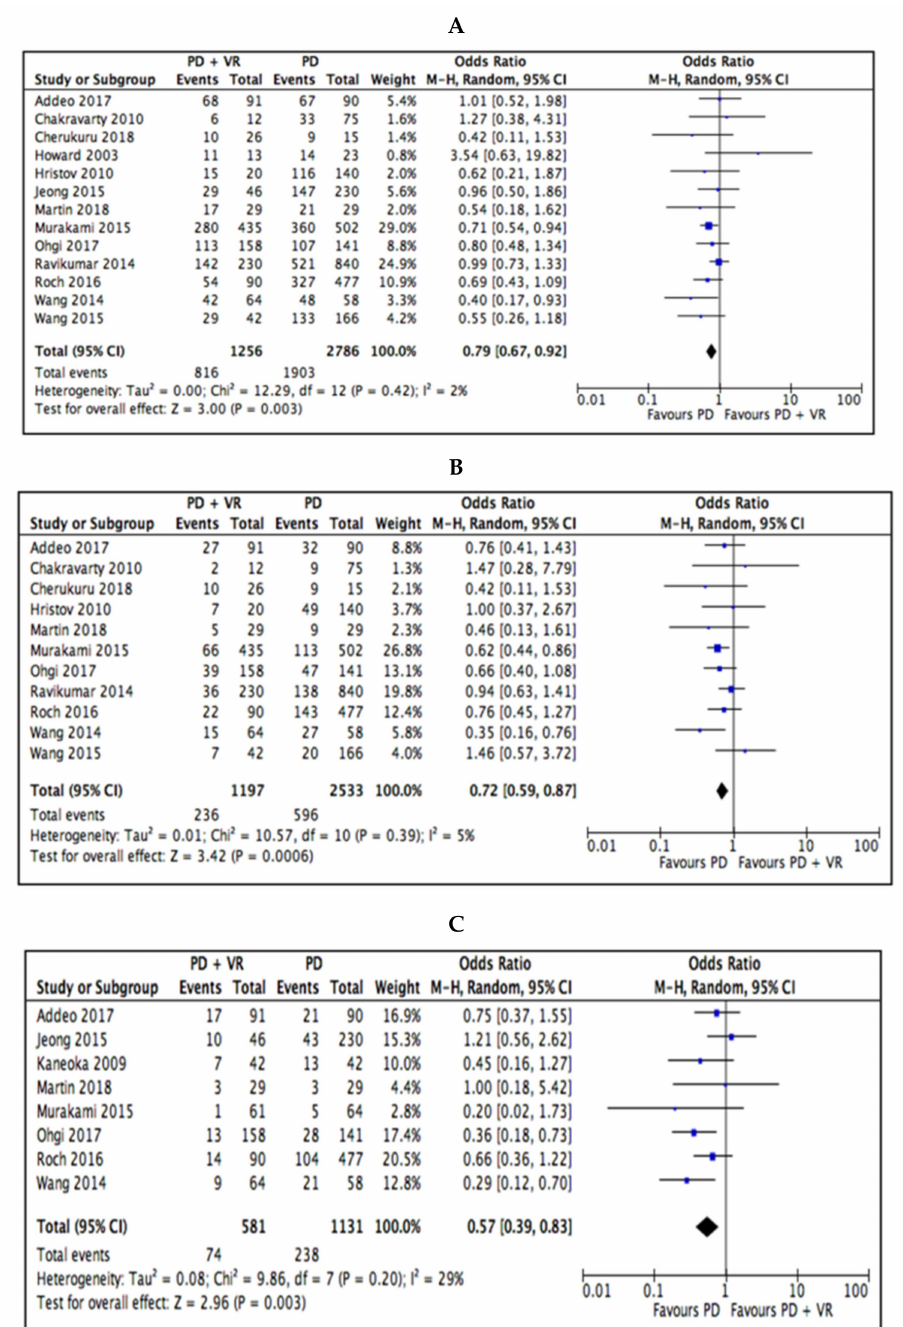
Figure 4. Meta-analysis of survival outcomes. ( A ) 1-year OS. ( B ) 3-year OS. ( C ) 5-year